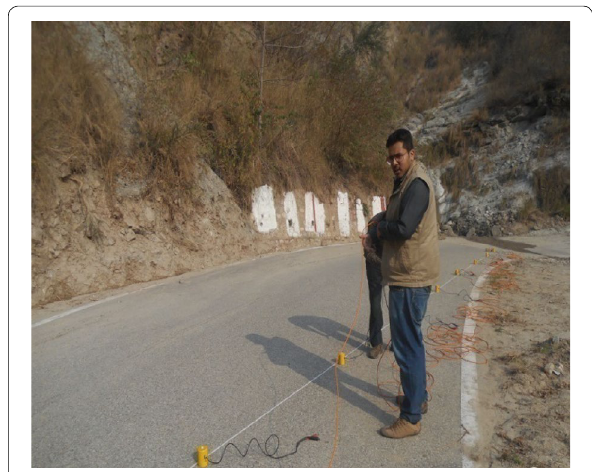
Fig. 3 A typical set of MASW testing conducted at Mansadevi landslide